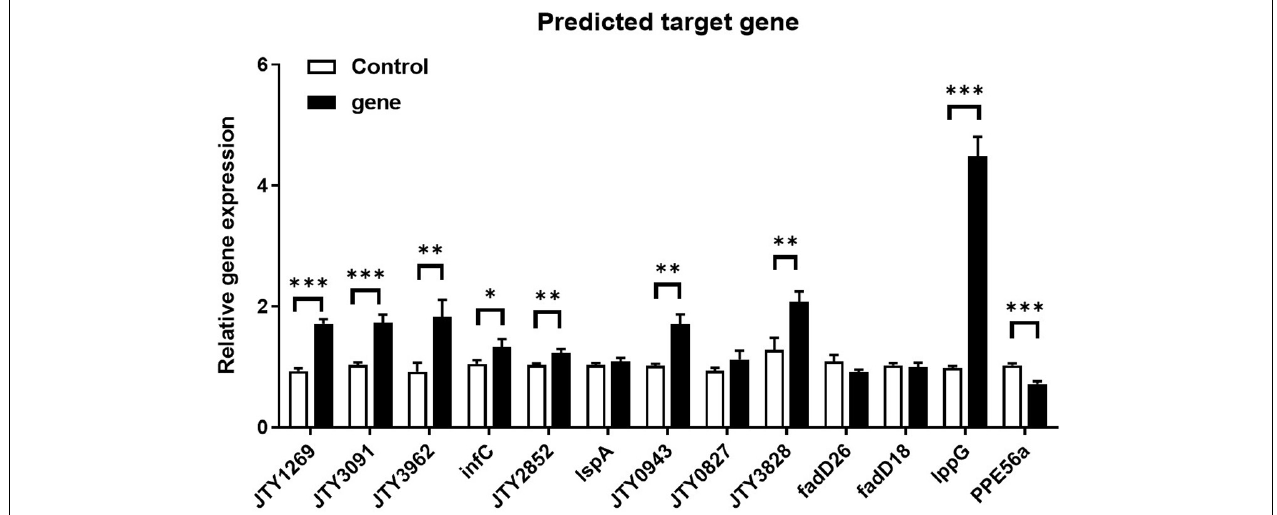
FIGURE 13 | Differential expression of ncBCG427 predicted target genes in BCG. ∗ p < 0.05; ∗∗ p < 0.01; ∗∗∗∗ p < 0.001 ( t